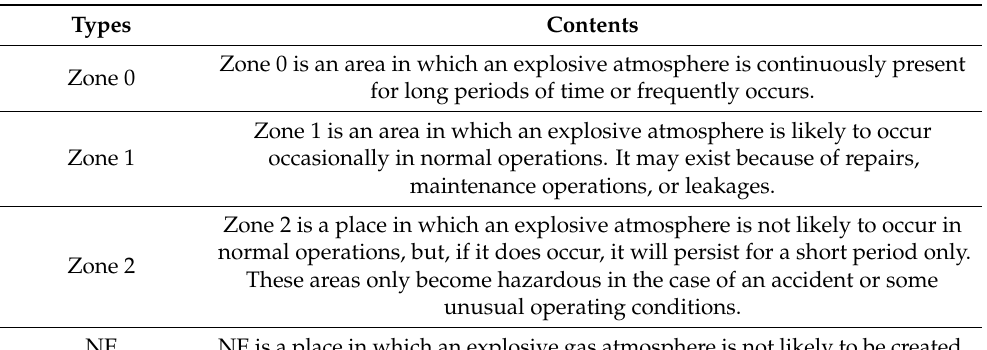
Table 1. Classification of hazardous explosion areas according to leakage